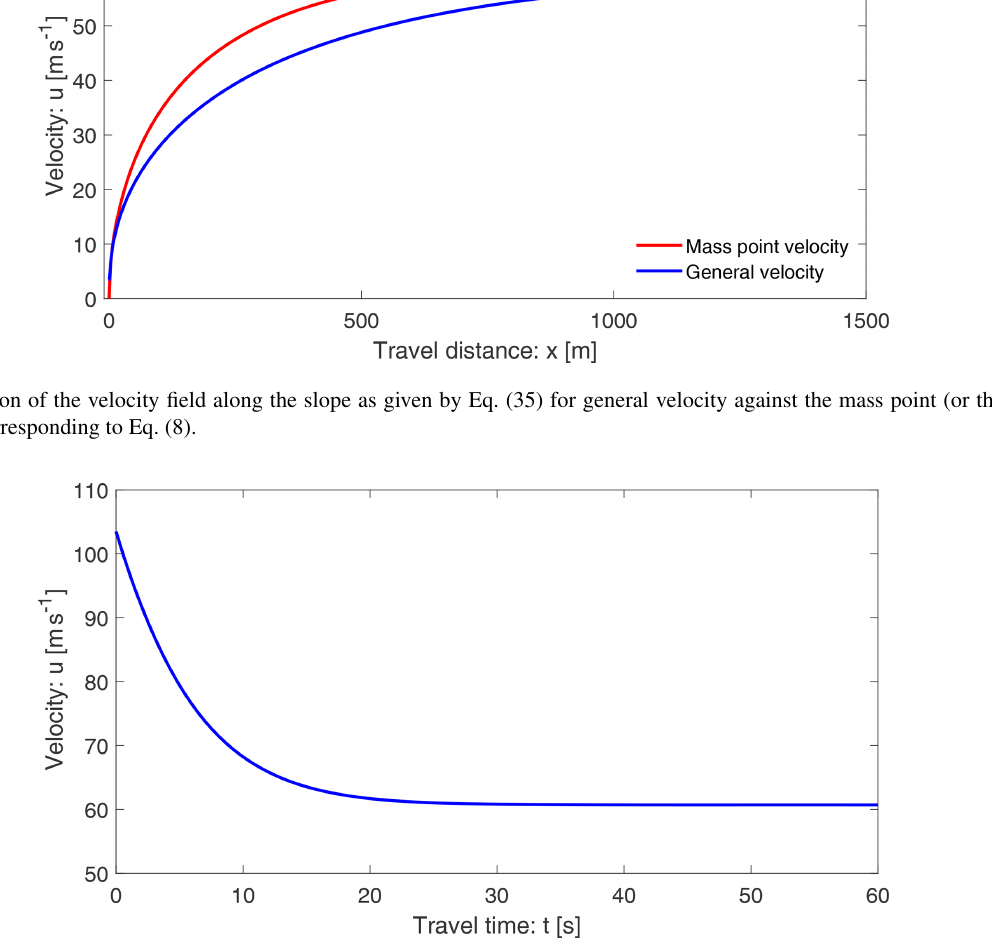
Figure 6. Time evolution of the velocity field as given by Eq.